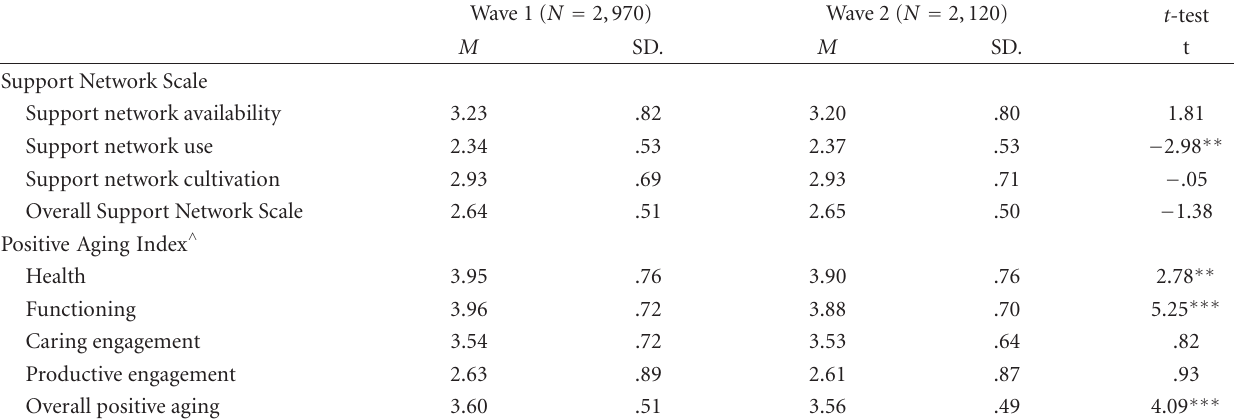
Table 1: Paired samples t -test of social network components and well-being components of Wave 1 and Wave 2 ( N = 2,120).